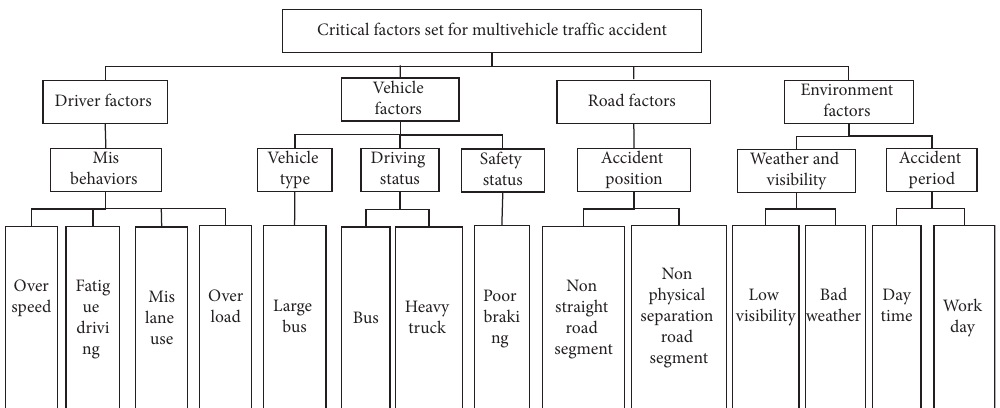
Figure 4: Critical factor set for the multivehicle traffic